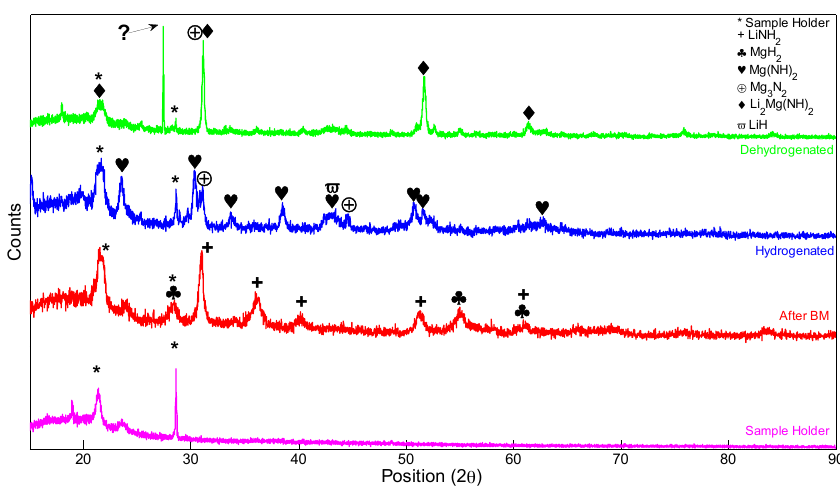
Figure 8. X-ray diffraction (XRD) spectra of LiNH 2 -nanoMgH 2 after ball milling and after PCT measurements in hydrogenated/dehydrogenated states.